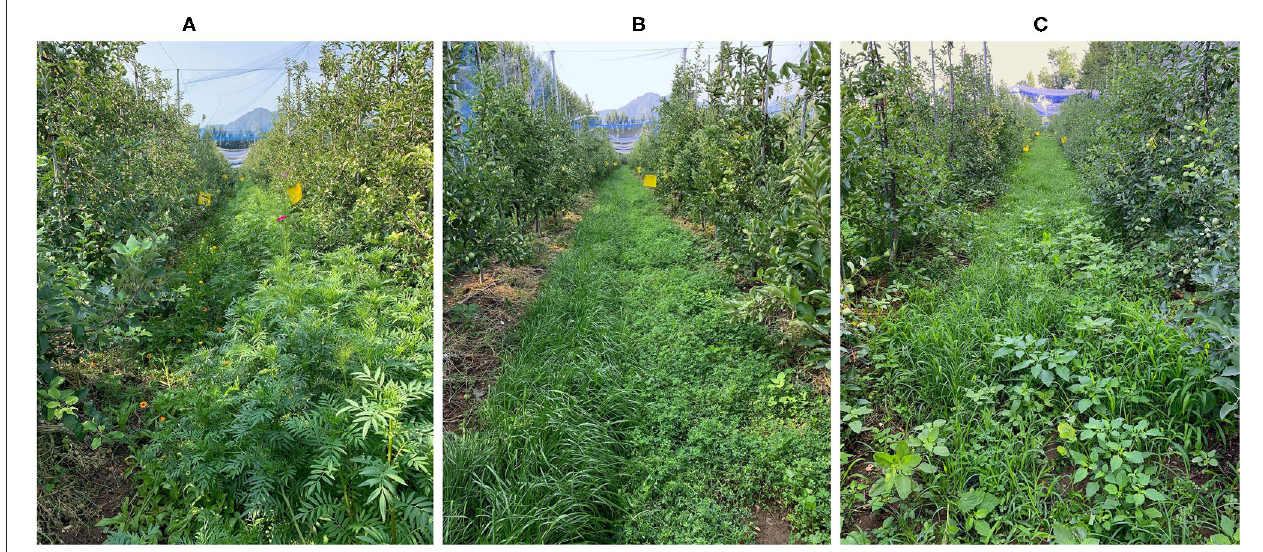
FIGURE 1 | Example of the cover plants in the three treatments: the sown flower strip (A) , the sown grass strip (B) , and the control (C) .